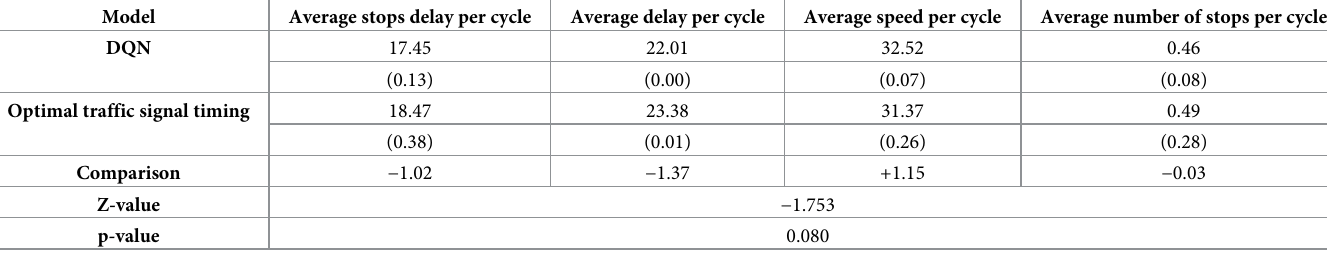
Table 2. Evaluation and validation results of scenario 1–1 in isolated